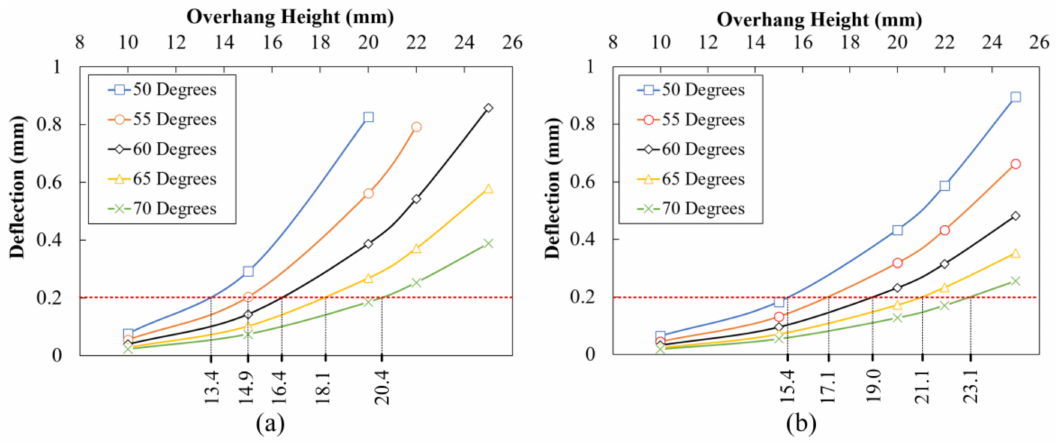
Figure 9. Vertical deflection of samples versus overhang height with different overhang angles: ( a ) parallelogram shape and ( b ) right trapezoid shape.